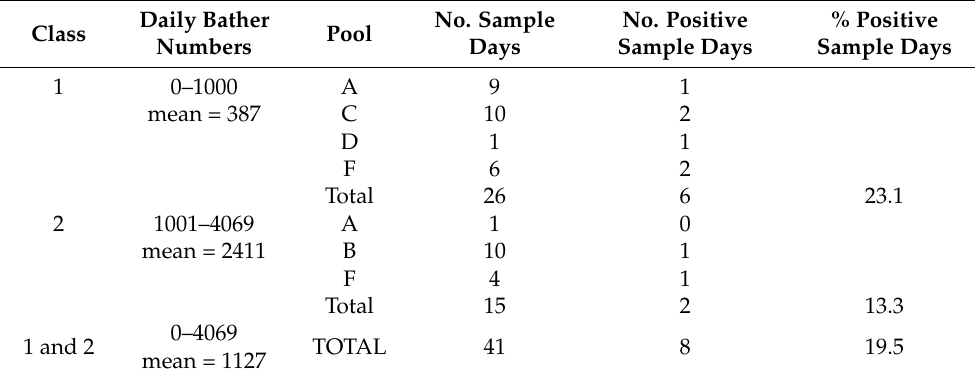
Table 5. Observed frequency of Cryptosporidium oocyst detection grouped by nominal classes of recorded bather numbers at five